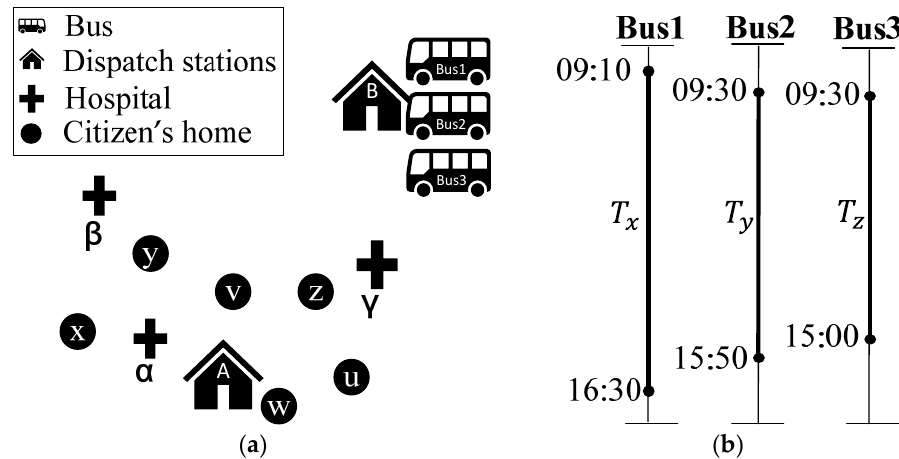
Figure 2. ( a ) City map with all three buses allocated to station B. ( b ) Timeline of the fleet (note there is not enough time for afternoon service).